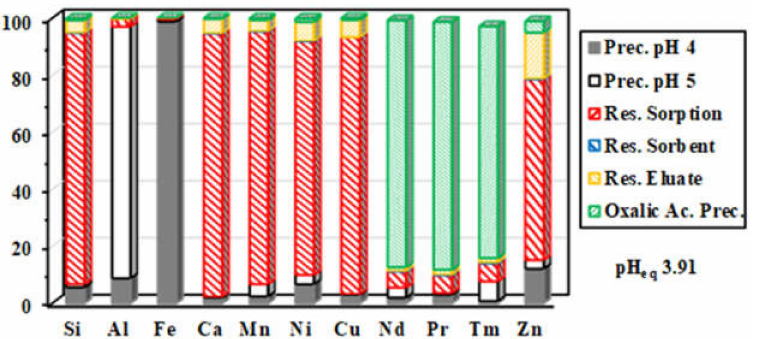
Figure 10. Distribution of the selected metals in the different compartments of the global treatment process (pH 4 precipitate (Fe); pH 5 precipitate (Al); residual solution after sorption at pH 0 5 (Res. Sorption); metal residue on the sorbent after elution (Res. Sorbent), residue in the eluate and oxalic acid